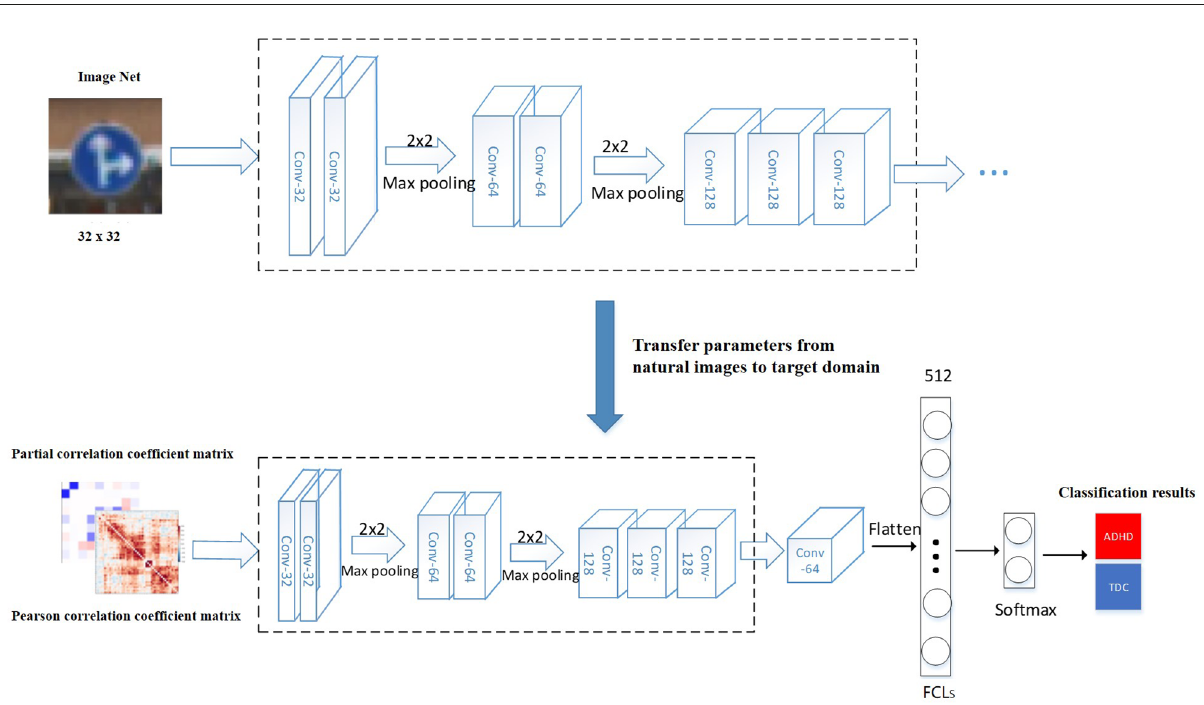
FIGURE1 ADHD classification model based on TLNN. The model training process including: (1) loading the pre-trained model, the pre-trained parameters were transferred to the target domain (fMRI image); (2) the hyperparameters obtained from the natural images were fine-tuned; (3) the VGGNet or ResNet50 models are trained on the large dataset ImangeNet; (4) the weight parameters completed by training are transferred to the fMRI image classification task; (5) the middle and lower layers of the pre-trained model are used as the feature extractor of the target task; (6) the extracted features are nonlinear mapped through the fully connected layer; and (7) the final classification result is obtained. Conv means the number of convolution kernels. FCLs means fully connected layers.